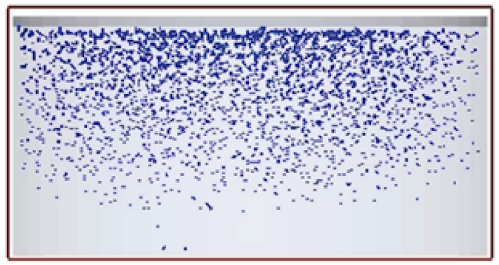
Fig. 18. Particle flow velocity in oedometer